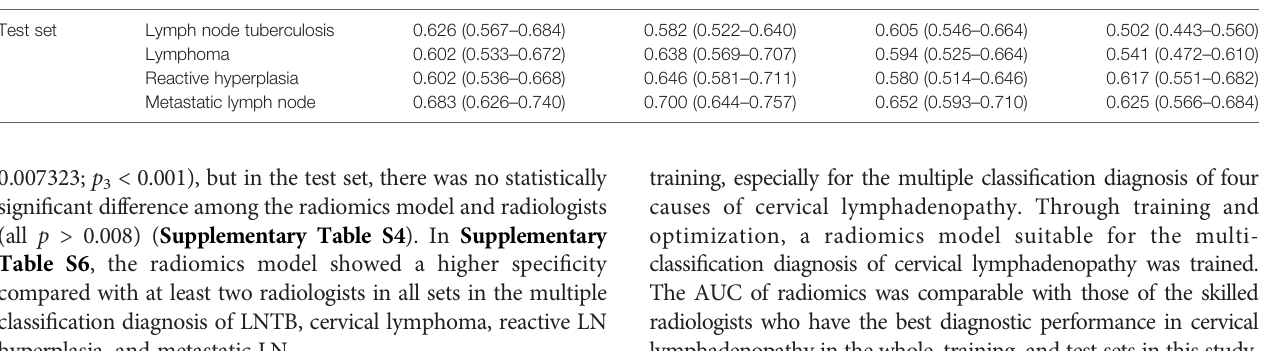
TABLE 4 | Area under the curve between the radiomics model and the senior radiologists in the test set. Data set